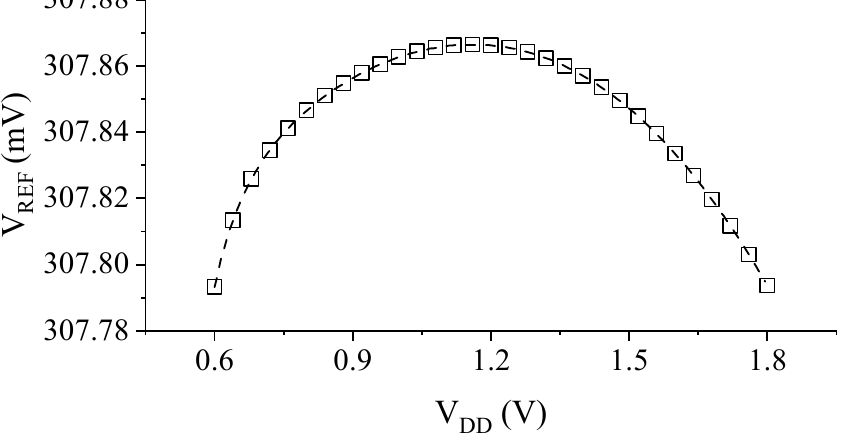
Figure 7. Simulated variation of V REF versus V DD in the suggested operating range of 0.6 V < V DD < Figure 7. Simulated variation of 𝑉 (cid:3019)(cid:3006)(cid:3007) versus 𝑉 (cid:3005)(cid:3005) in the suggested operating range of 0.6 V < Figure 7. Simulated variation of 𝑉 (cid:3019)(cid:3006)(cid:3007) versus 𝑉 (cid:3005)(cid:3005) in the suggested operating range of 0.6 V < 𝑉 (cid:3005)(cid:3005) < 1.8 V . 1.8 𝑉 (cid:3005)(cid:3005) < 1.8 V .